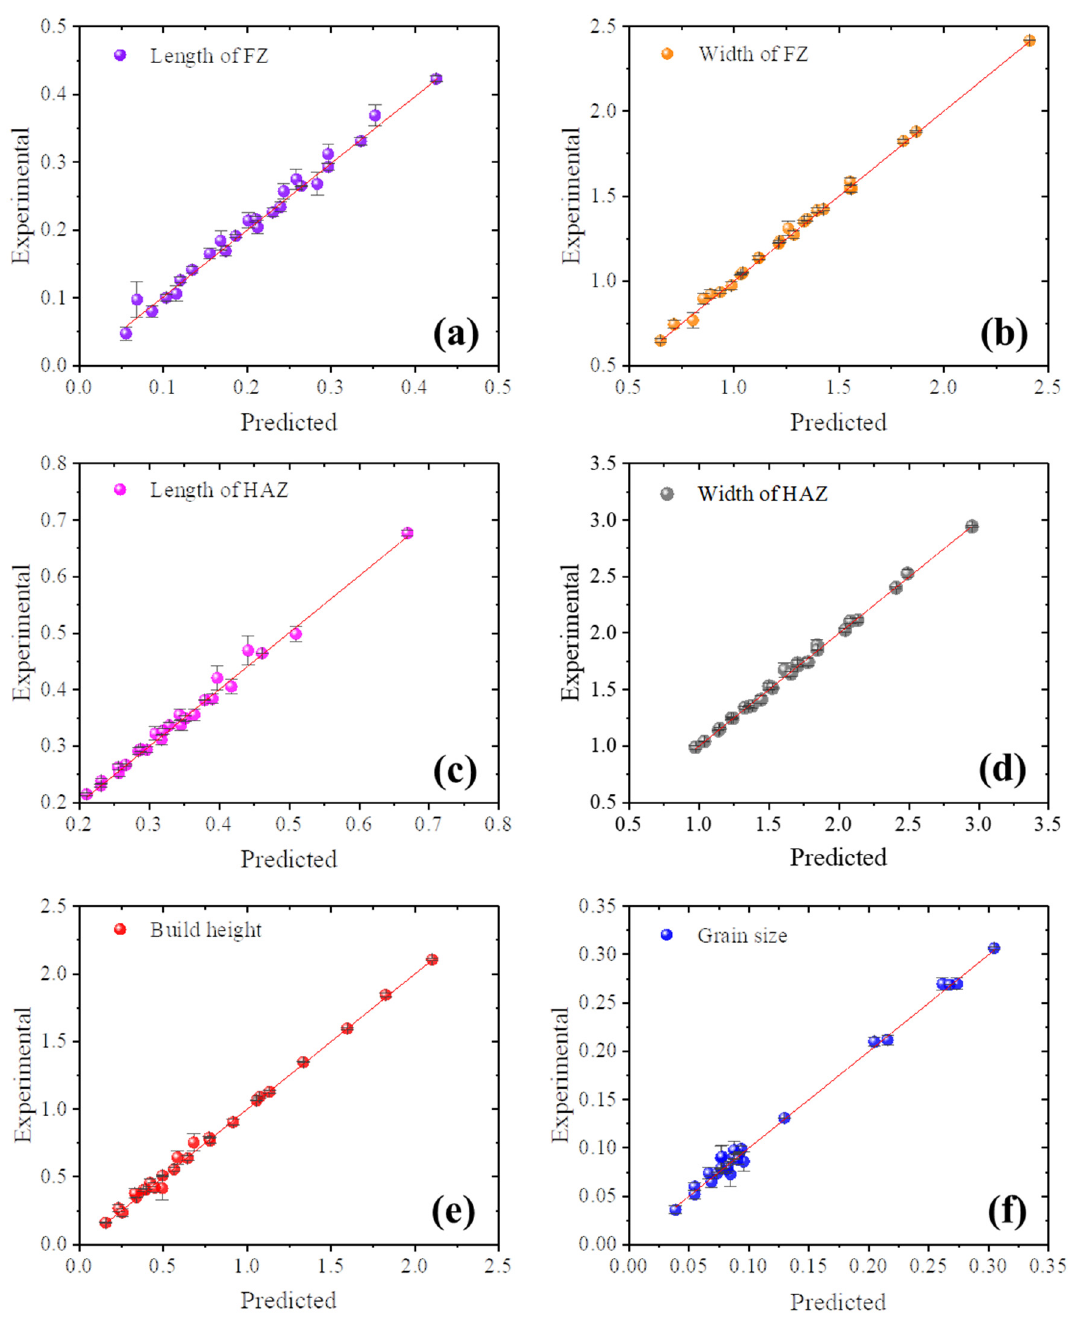
Figure 3. Correlation plots showing the experimental versus predicted results of the ( a ) length of the fusion zone (FZ), ( b ) width of the FZ, ( c ) length of the heat-affected zone (HAZ), ( d ) width of the HAZ, ( e ) deposit height, and ( f ) grain size. All values are in mm.